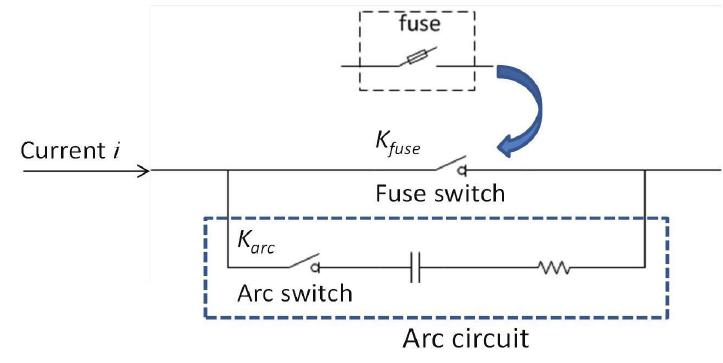
Figure 1. Equivalent fuse